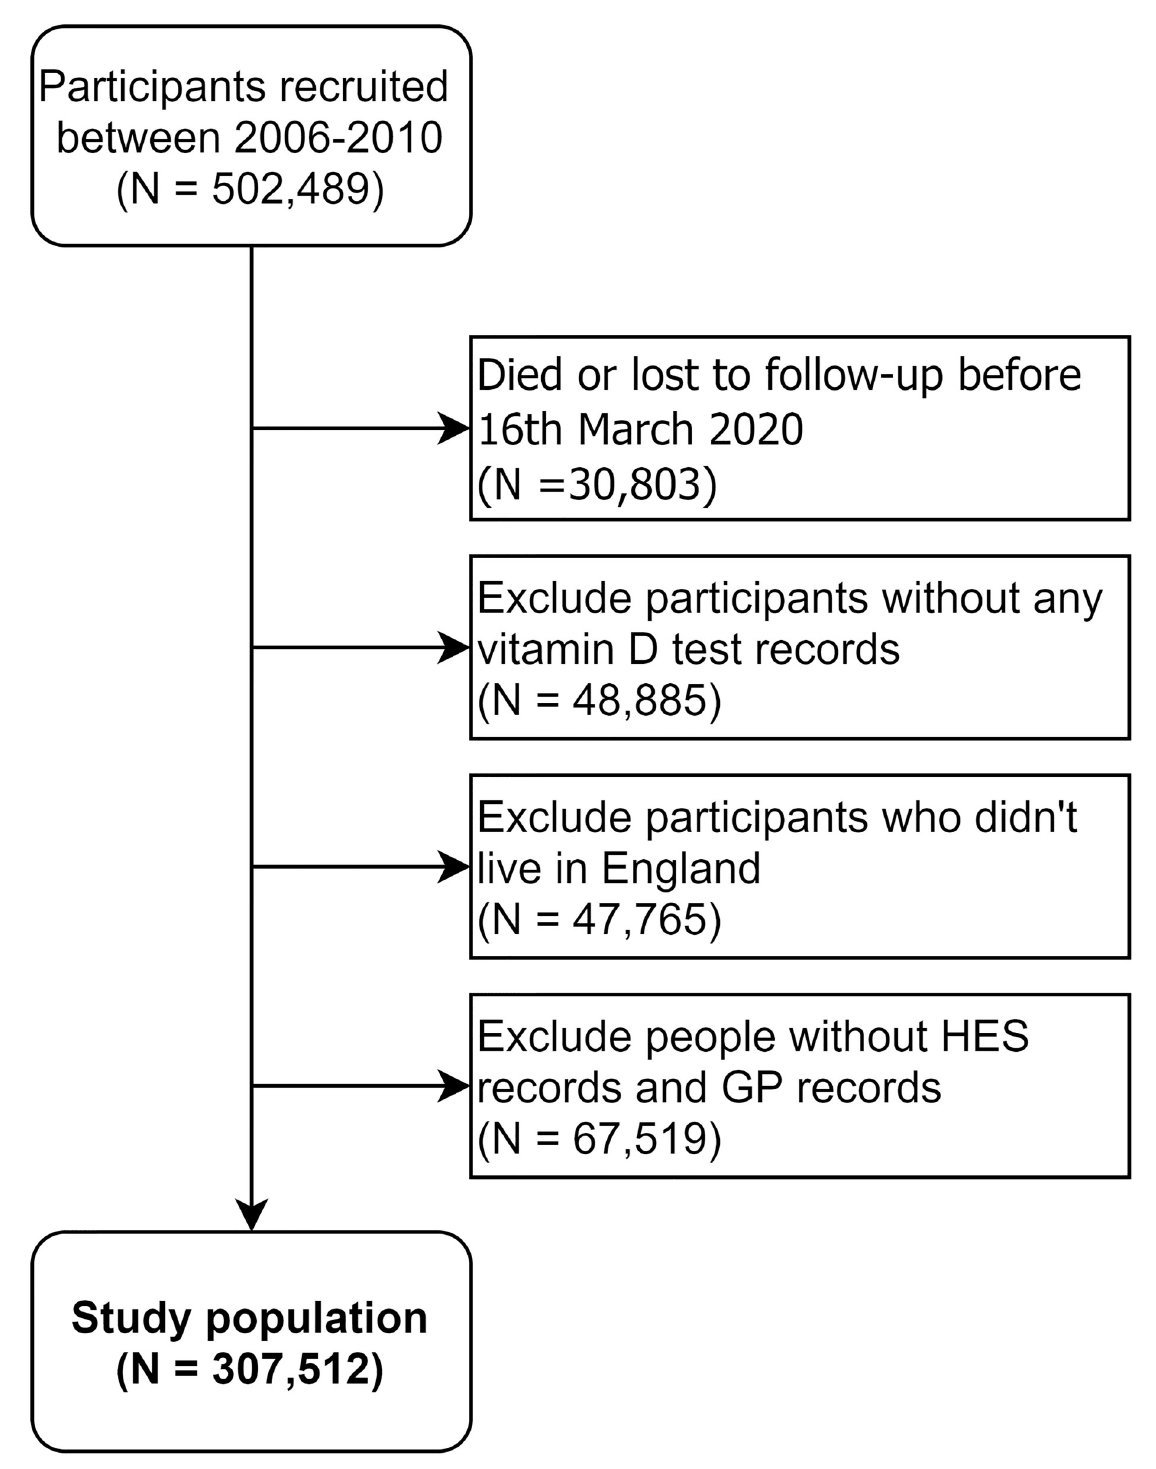
Fig 2. Diagram of selecting study